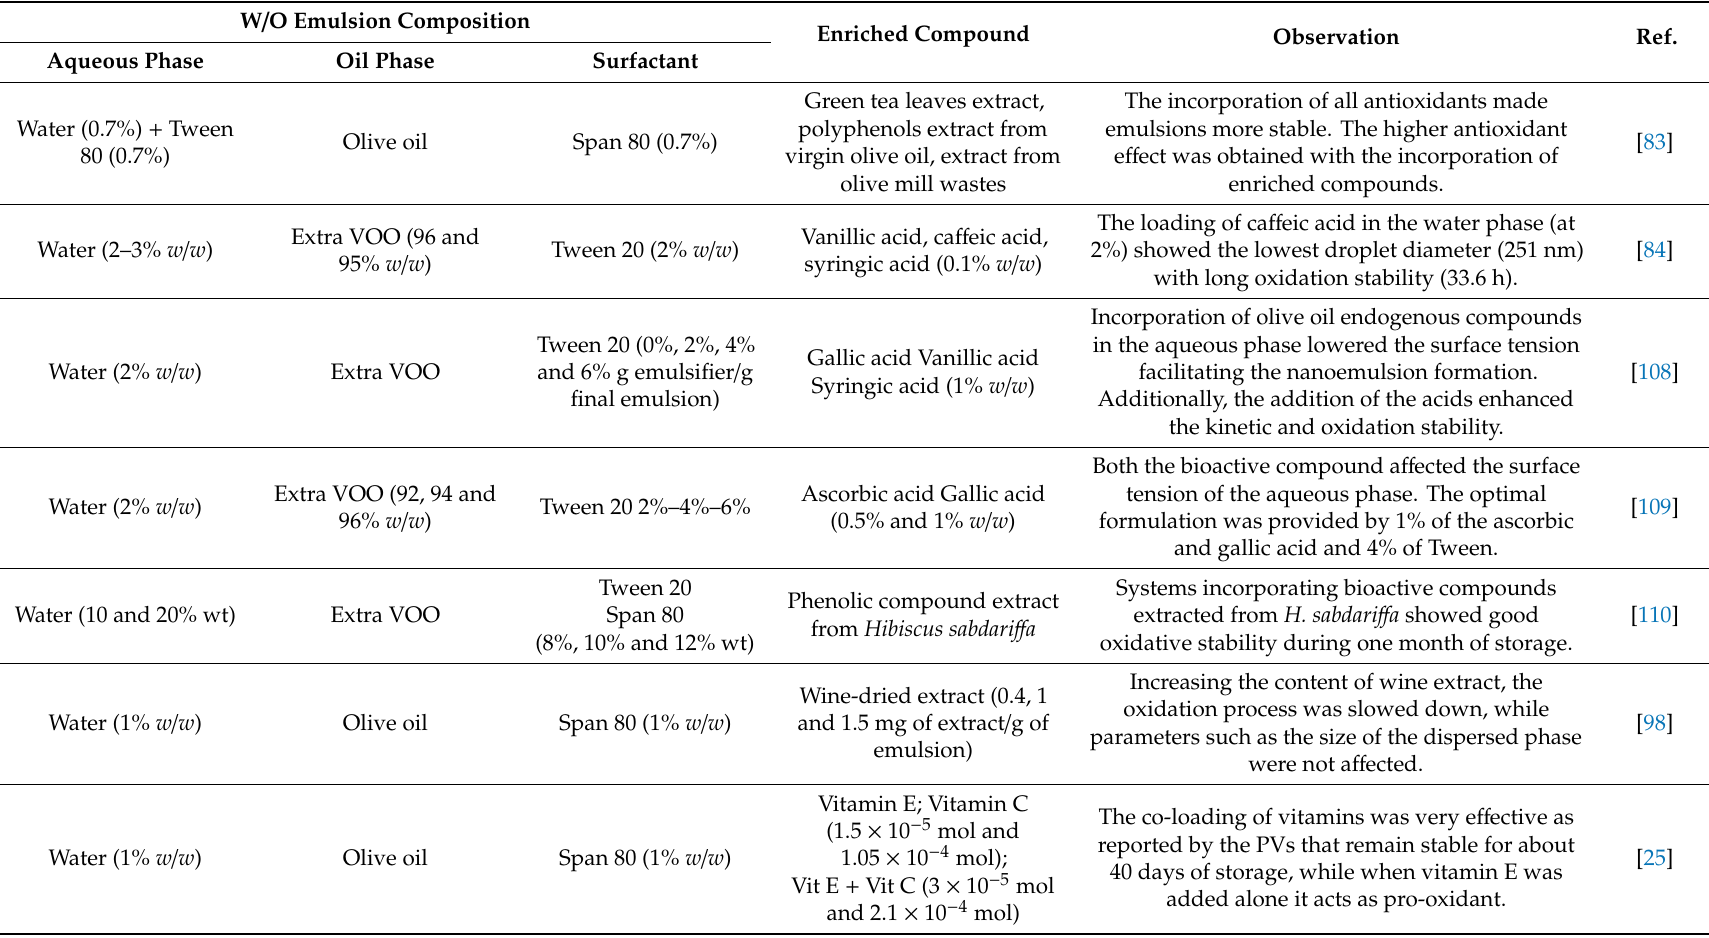
Table 2. Examples of W / O emulsion enriched with active